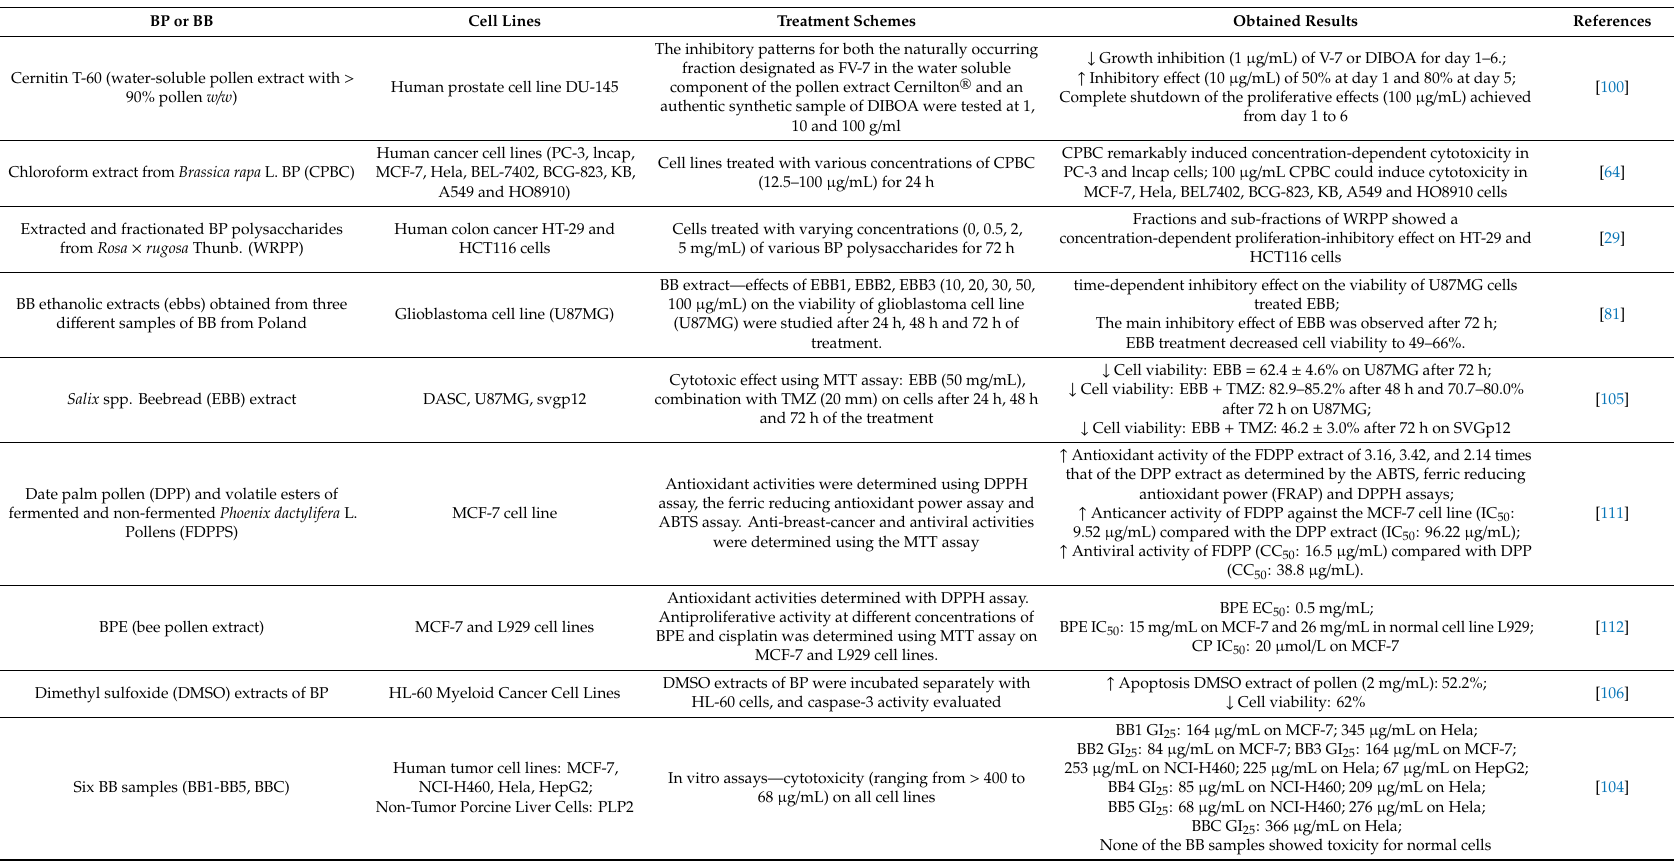
Table 3. In vitro summary of the main studies regarding the e ff ect of BP and BB on multiple cancer and non-cancer cell